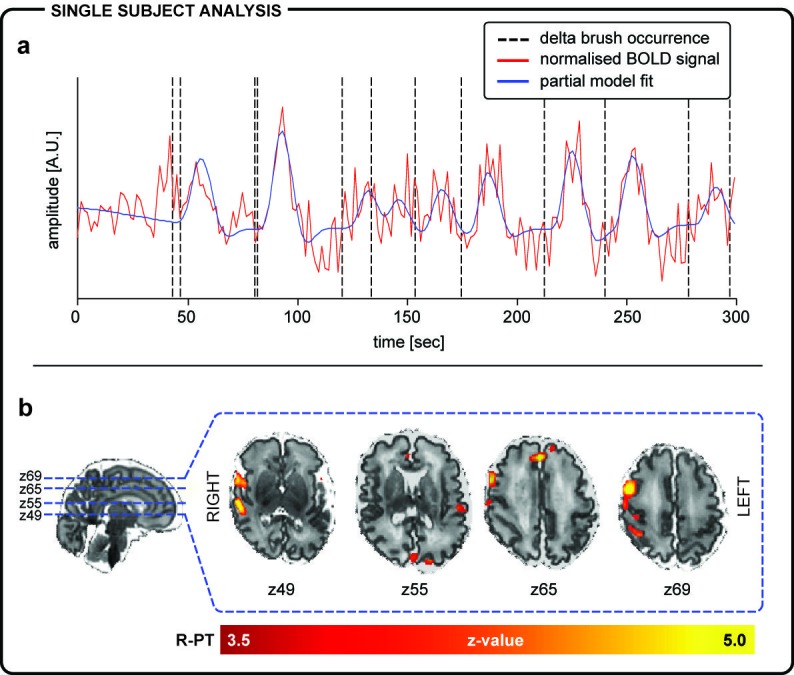
Example of subject level analysis.Hemodynamic activity correlated to right posterior-temporal delta brushes in a single infant of 35 + 1 weeks PMA. (a) Right posterior-temporal delta brush occurrence as identified by EEG (dashed vertical lines) was convolved with an age-appropriate hemodynamic response function to generate a general linear model regressor (blue) to fit to the acquired BOLD time series (red) for fMRI analysis. (b) Right posterior-temporal delta brush occurrence was significantly associated with well localized clusters of BOLD activity (red-yellow) in the right temporal pole and superior temporal lobe (z49); the left parietal operculum (z55); the anterior cingulate and right fronto-parietal lobes (z65 and z69). Images show the thresholded z-statistical map with a corrected cluster significance of p<0.05 overlaid on the subject’s T2-weighted image.